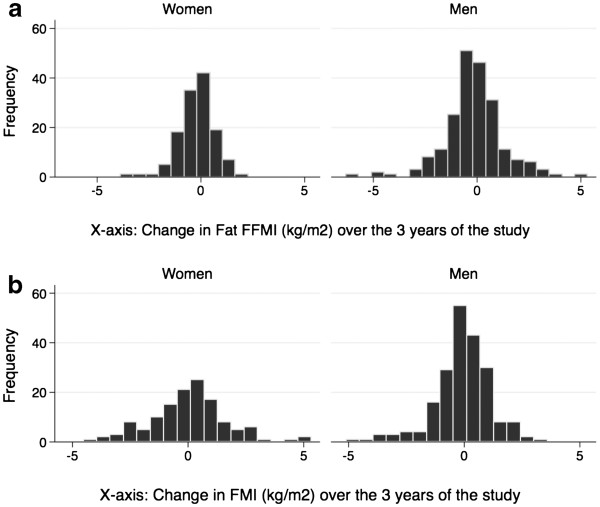
 Distribution of change in fat free mass index (FFMI) and fat mass index (FFMI) (kg/m2) over the 3 years of the study.